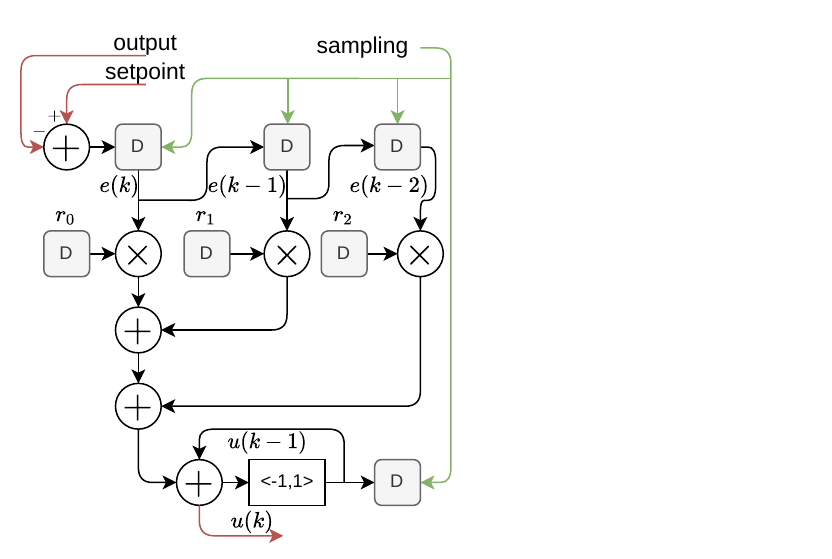
Figure 4. Automatically generated multipliers with summation as seen in the Quartus software.